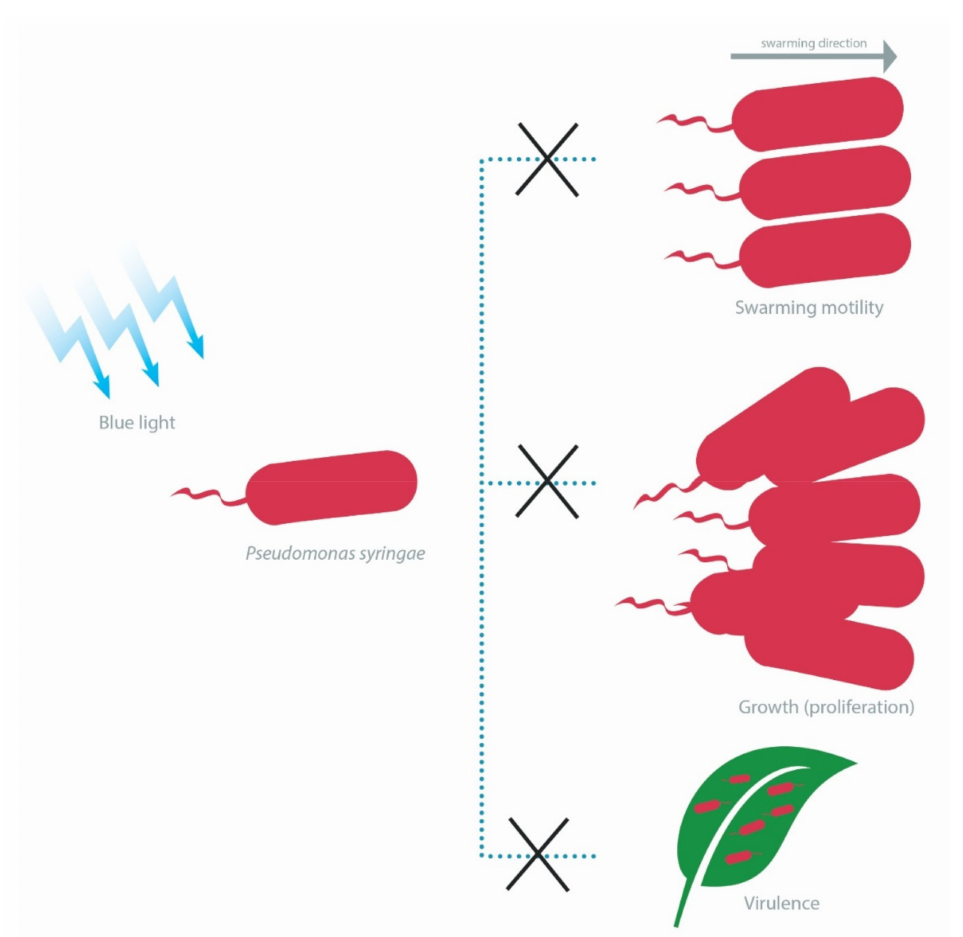
Figure 3. Blue light inhibits swarming motility, growth and virulence of Pseudomonas syringae